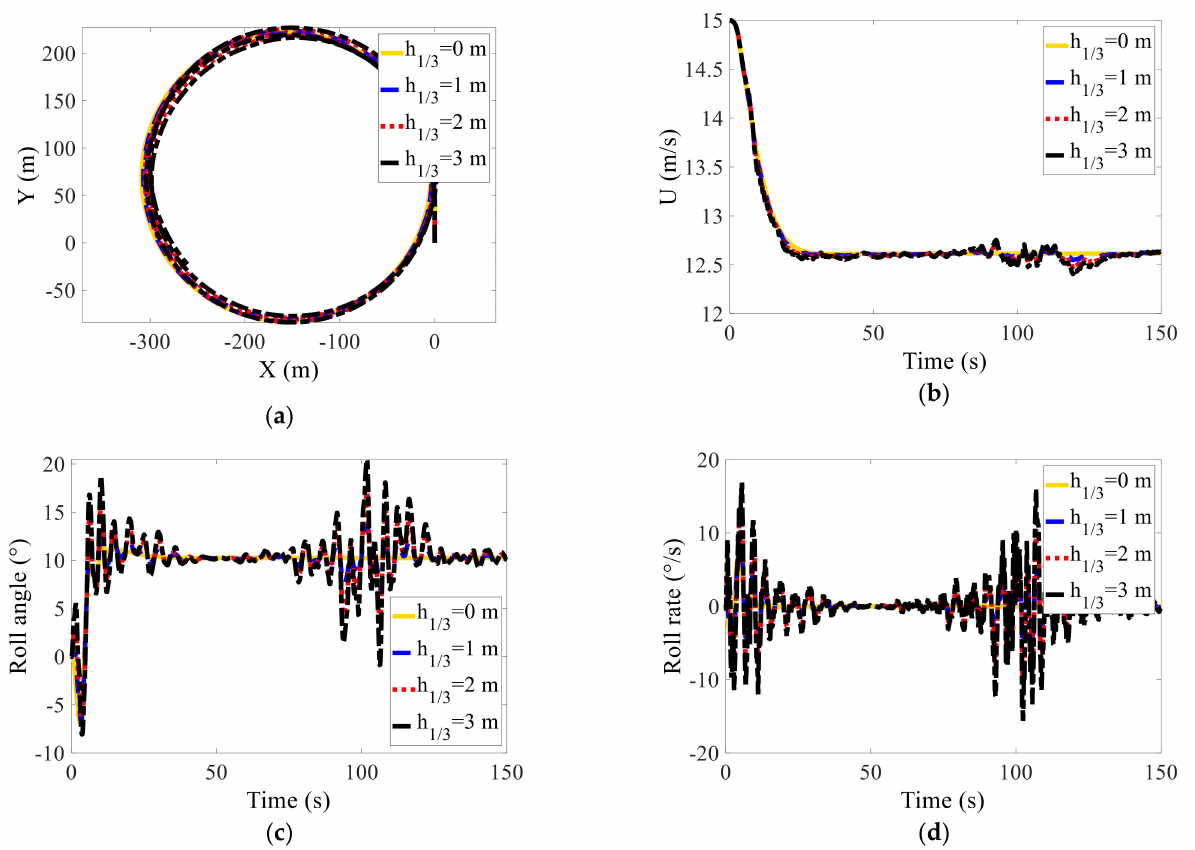
Figure 2. Simulation results of ship turning motion under different sea states. ( a ) Trajectory; ( b ) ship speed; ( c ) roll angle; ( d ) roll